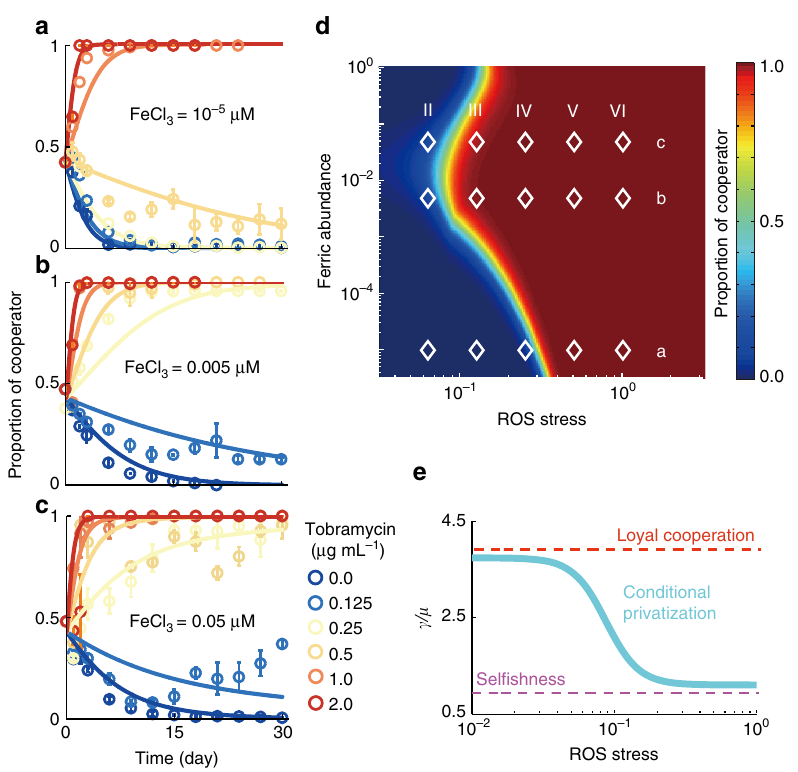
Fig. 4 Conditional privatization stabilizes bacterial cooperation in the presence of environmental stresses. a – c Direct evolution of the producer (cooperator, wild-type) and non-producer strain (cheater, Δ pvdA mutant) of PVDI in the presence of different amounts of FeCl 3 ( a 1 × 10 − 5 μ M ), ( b 0.005 μ M ), and ( c 0.05 μ M ) and different amounts of tobramycin (0.0 to 2.0 μ gmL (cid:1) 1 ), where symbols and lines represent the experimental data and the theoretical calculations, respectively. The fi nal concentration of tobramycin in each panel is 0.0, 0.125, 0.25 0.5, 1.0, and 2.0 μ gmL (cid:1) 1 , from bottom to top, respectively. d Producer fraction as a function of the ferric abundance and the normalized ROS stress, where the normalized ROS stress = [Tobramycin]/ IC 50 , the symbol [] represents the concentration, IC 50 = 2.0 μ gmL (cid:1) 1 . Colors represent the fraction of producers in the end of direct evolution, red or blue color indicates the cooperator or cheater dominated, respectively. Symbols represent the evolutionary outcomes arising from experiments in the presence different amount of ferric ions or tobramycin; i.e., 10 − 5 μ M ( a ), 0 : 005 μ M ( b ), 0.05 μ M ( c ) FeCl 3 , 0.125 (II), 0.25 (III), 0.5 (IV), 1.0 (V), 2.0 (VI) μ gmL (cid:1) 1 tobramycin. e Schematic showing the principle response curves of the ef fl ux of the public goods in the presence of various environmental stresses, where the curve with cyan, red or magenta color represents the conditional privatization, loyal cooperation or sel fi shness respectively. The error bars in a – c are the standard deviation of experimental